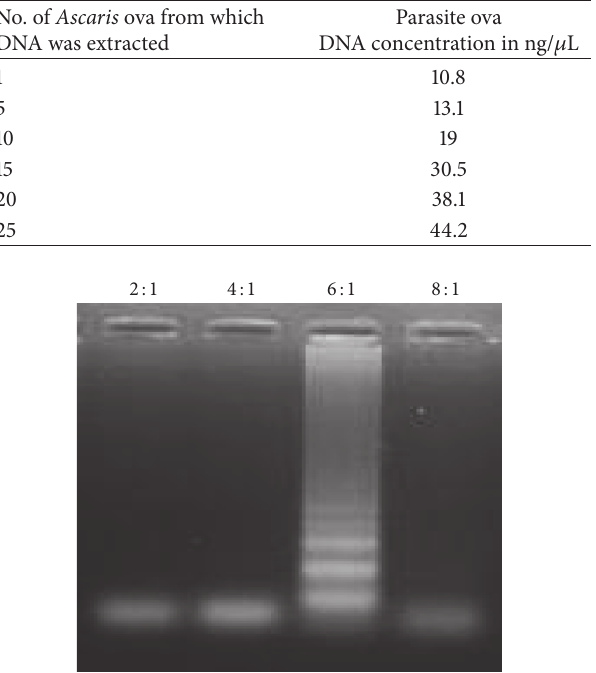
Table 2: The concentration of DNA quantified using NanoDrop 2000 (Thermo Scientific) obtained for varying amounts of parasite ova.